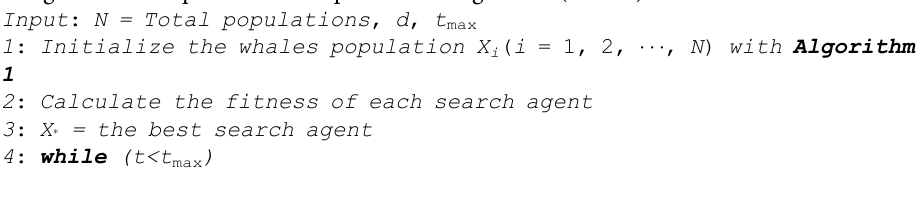
Algorithm 2. Improved whale optimization algorithm (IWOA).